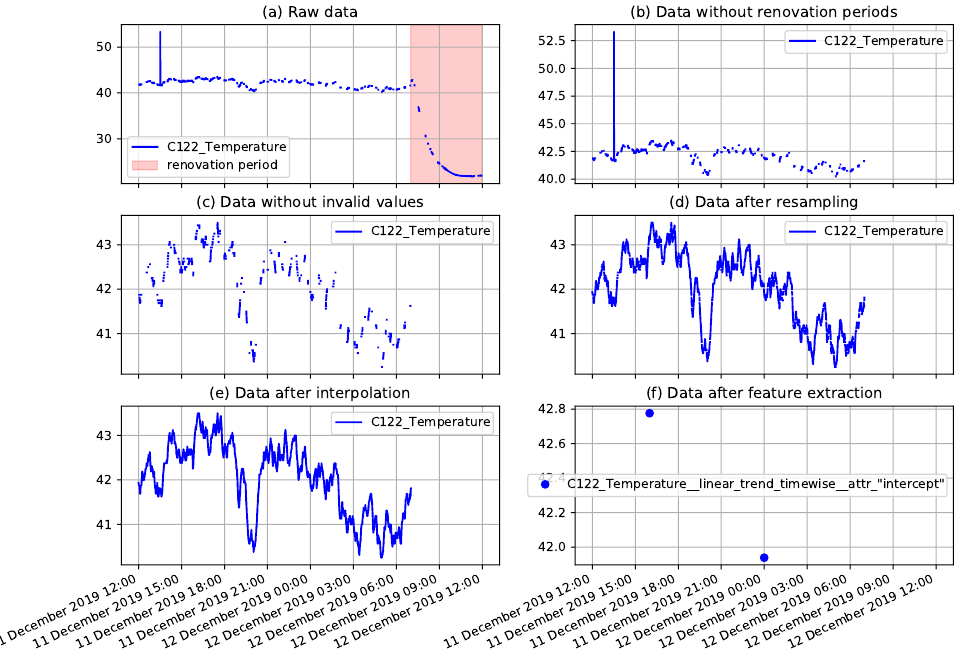
Figure 7. Example plots of coal crusher temperature measurements illustrating consecutive prepro- cessing steps including: The removal of renovation periods, removal of invalid values, resampling, interpolation, and extraction of derived